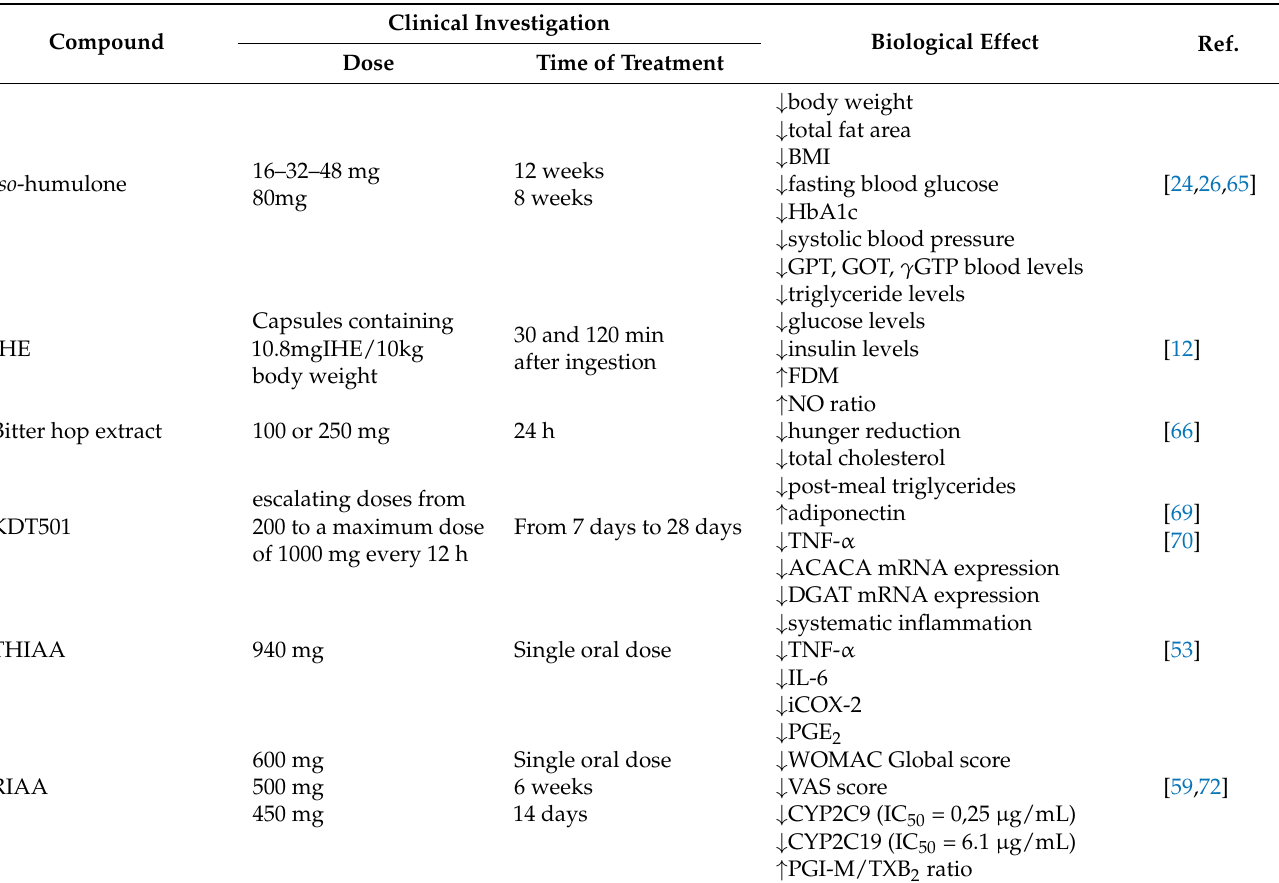
Table 3. Description of the principal clinical effects of hop isomerized